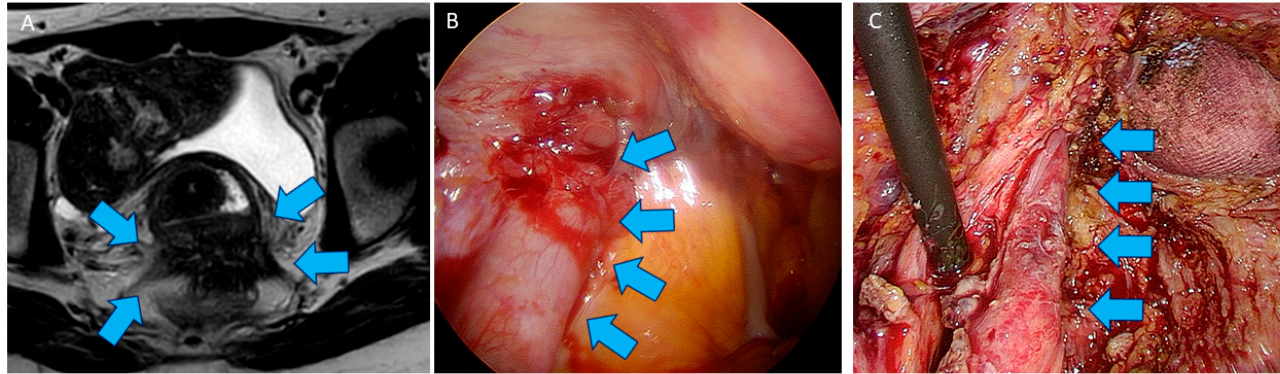
Figure 4. ( A ) Pelvic MRI showing a T2-weighted axial view of a DE large nodule (blue arrow) infiltrating the anterior rectal wall. The nodule extends to the lateral part to both ureters. ( B ) Laparoscopic view of the left ureter with hydronephrosis (blue arrow) due to a rectovaginal DE nodule also infiltrating the bowel. ( C ) Laparoscopic view of the left ureter after ureterolysis (blue arrows). After ureterolysis and removal of the fibrotic ring, left ureter returns to normal diameter.